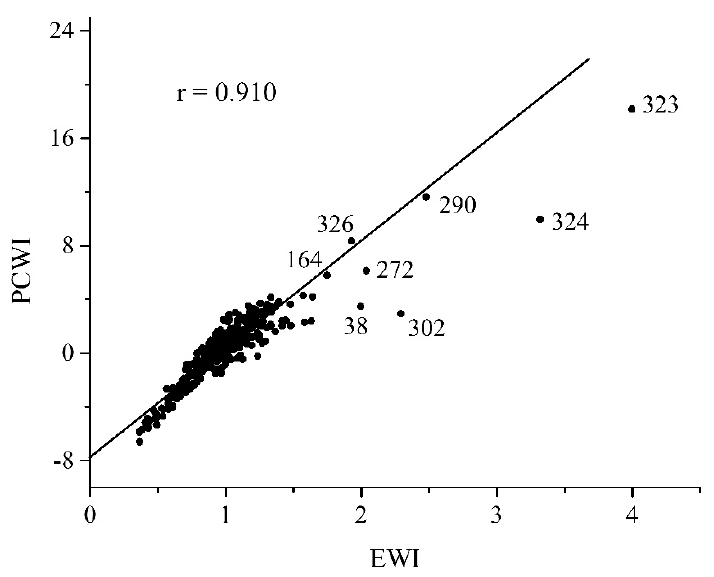
Figure 5. Linear regression between principal component weighted index (PCWI) and EWI.